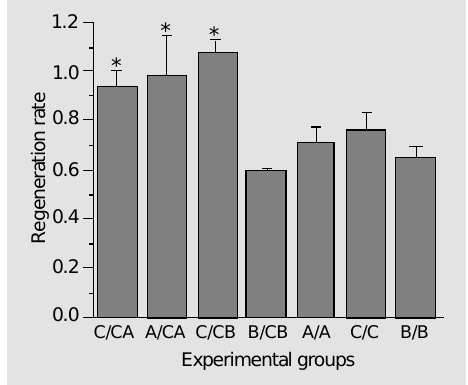
Figure 5 - Regeneration rate obtained by the division of total number of axons in the regenerated nerves by the number in the contralateral nerves.